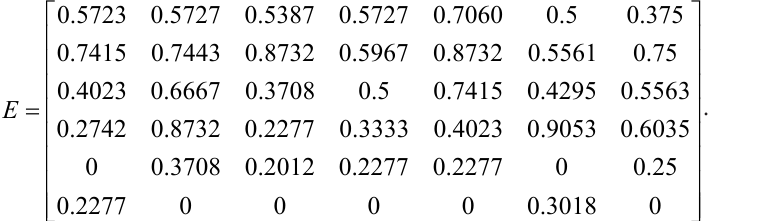
Table 2. Results obtained by hesitant fuzzy distance d